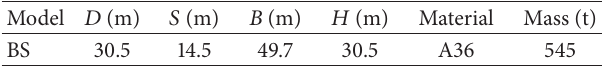
Figure 6: Container crane (bare structure). Table 2: Container crane properties used in